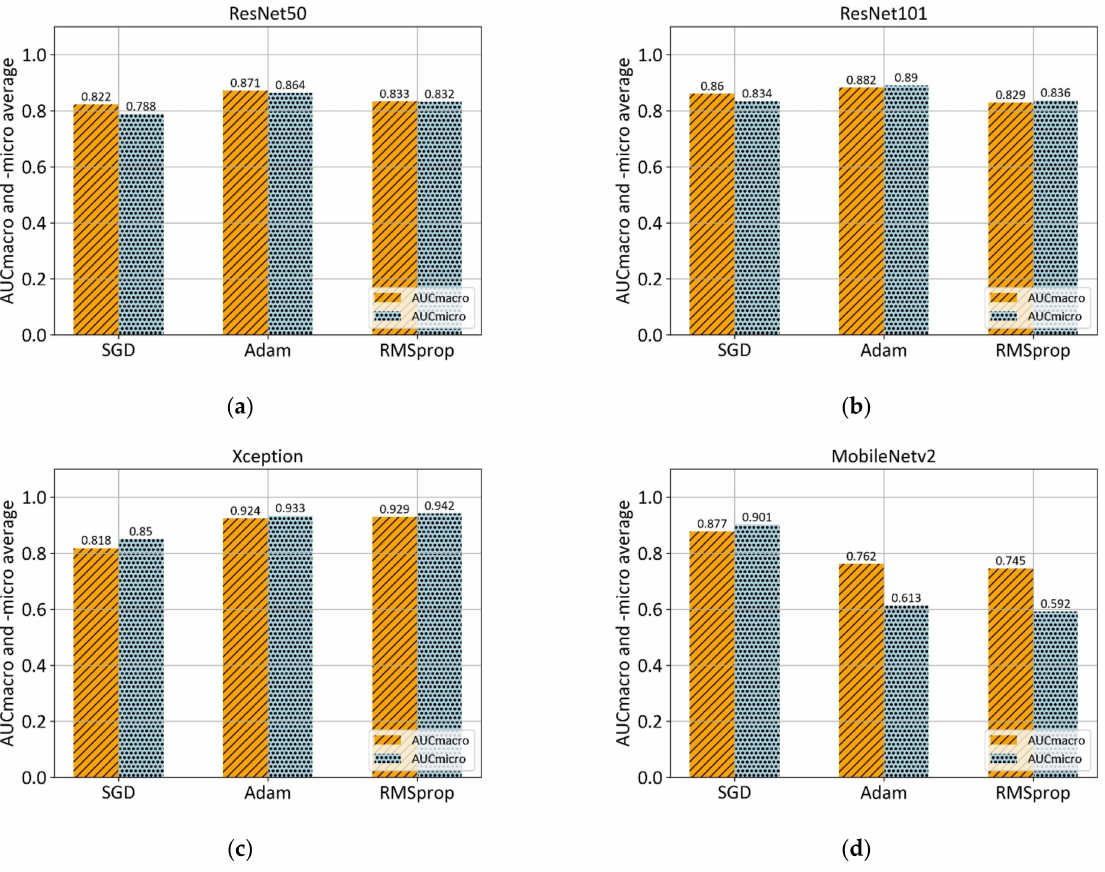
Figure 7. Comparison of mean AUC macro and -micro values of three different optimizers (SGD, ADAM, and RMSprop) on pre-trained models: ( a ) ResNet50; ( b ) ResNet101; ( c ) Xception; and ( d )